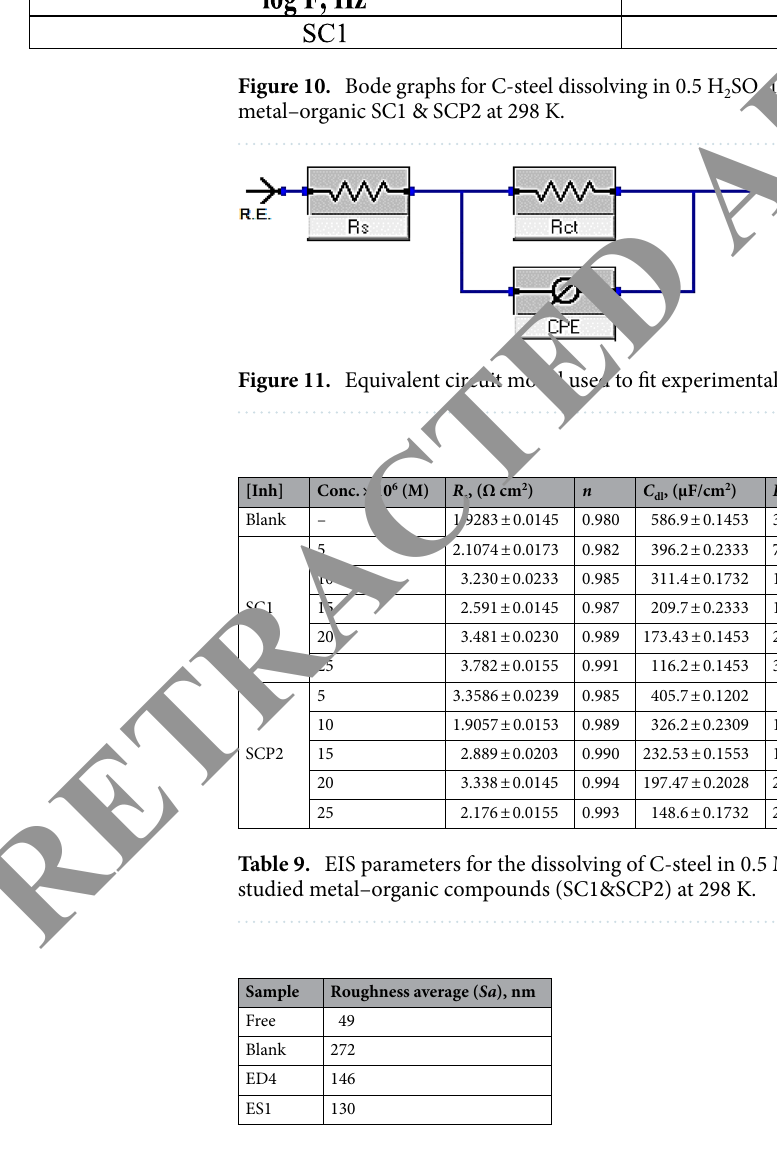
Table 10. Shows AFM data for the surfaces of SC1 and SCP2 with and without the inhibitor 0.5 M H 2 SO 4 .